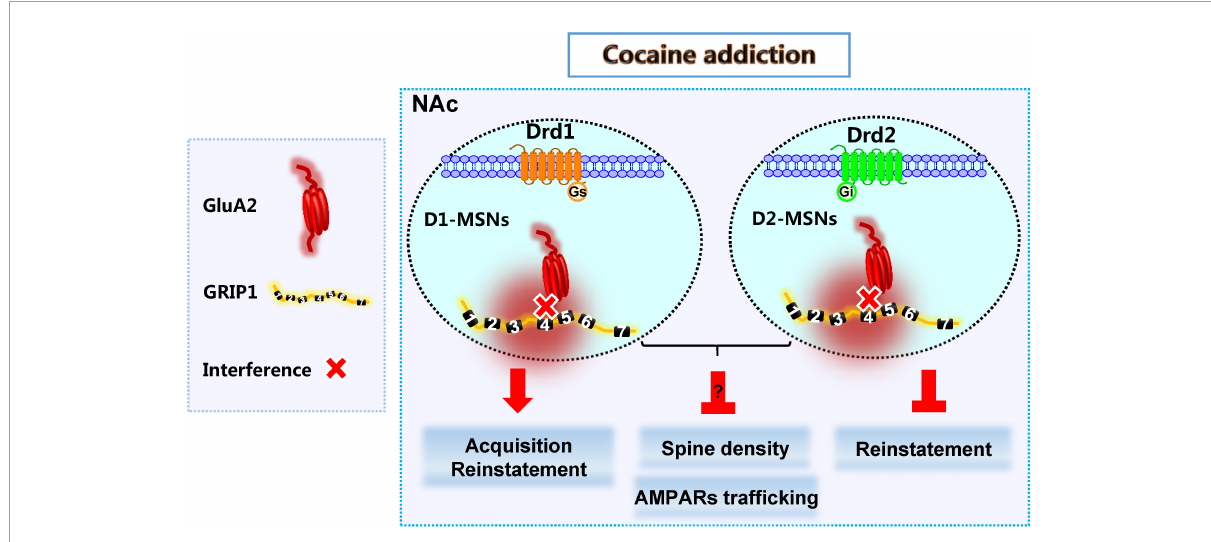
FIGURE9 GRIP1 in D1-MSNs and D2-MSNs differentially regulates cocaine acquisition, reinstatement, and associated spine